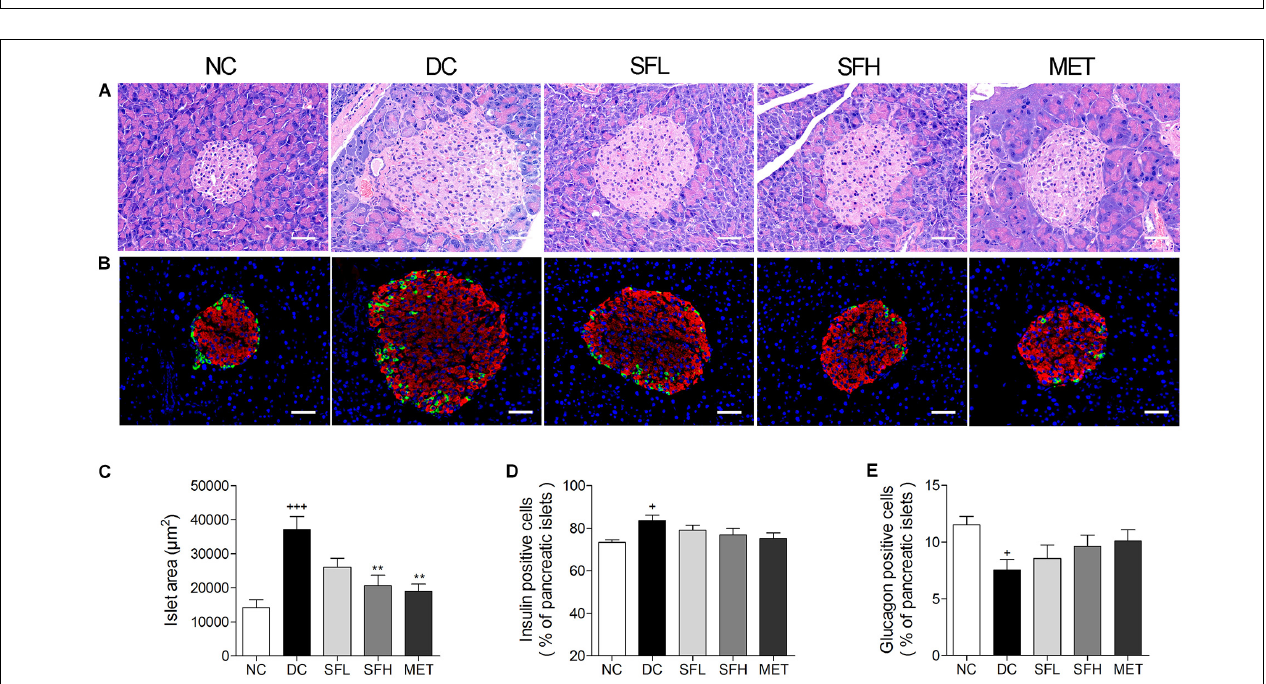
FIGURE 8 | SD-FRE treatment reversed islet hypertrophy in pancreas of KK-Ay mice. (A) Pancreas sections were stained with HE and observed under light microscopy. (B) Pancreas sections were stained with insulin (red), glucagon (green) and DAPI (blue), observed under fluorescence microscopy. Scale bar, 50 µ m. Quantified average islet area (C) , the percentage of insulin-positive beta cells (D) and glucagon-positive alpha cells (E) in pancreatic islets. Data are mean ± SEM. n = 4 sections per group. + p < 0.05, +++ p < 0.001 vs. NC group, ∗∗ p < 0.01 vs. DC group.